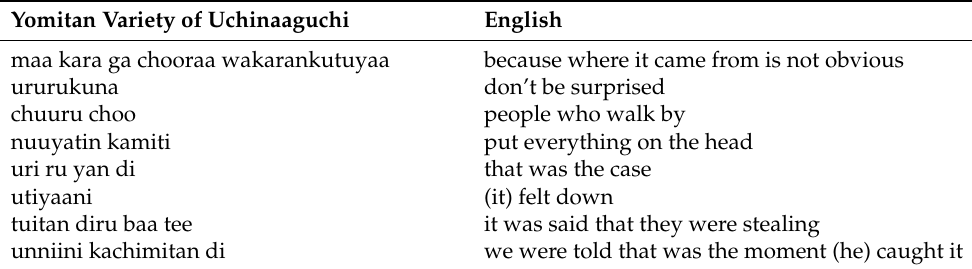
Table 8. Short expressions from the story.